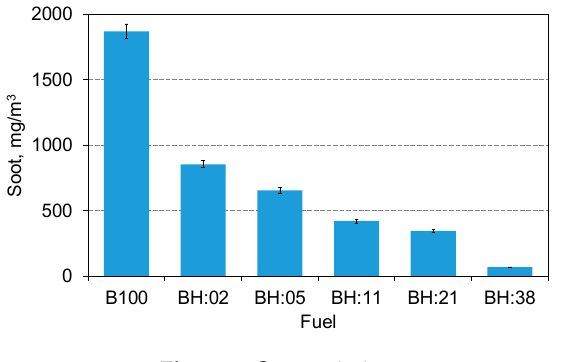
Figure 9. Soot emission. Figure 9. Soot